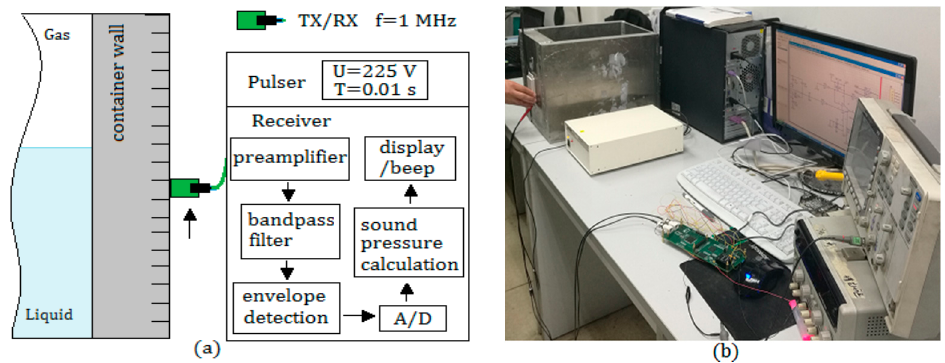
Figure 7. Measurement system: ( a ) TX/RX is a transducer with transmitting and receiving function; and ( b ) calibration devices in the experiments.